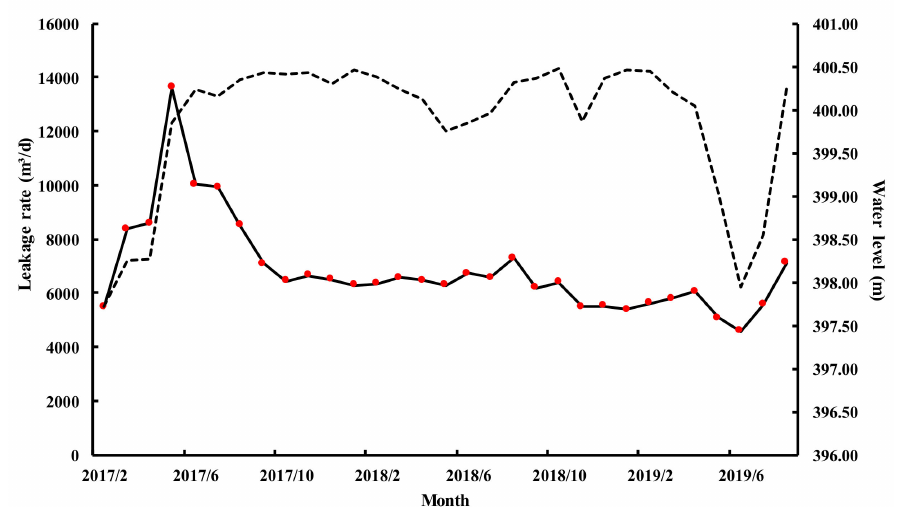
Figure 10. The reservoir water level and leakage process of the